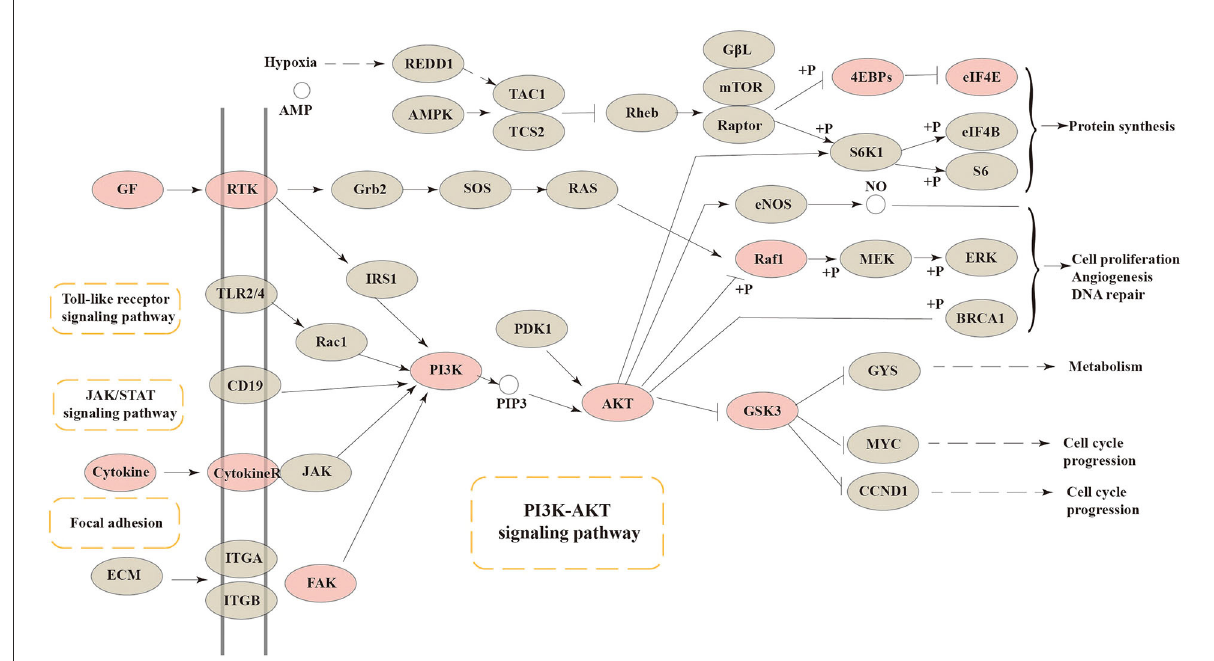
FIGURE6 The Kyoto Encyclopedia of Genes and Genomes (KEGG) pathway enrichment analysis showed that various targets of the PI3K-AKT signaling pathway were tightly associated with the peptides’ pharmaceutical actions. The red nodes represent the genes could be regulated or affected by fermented egg-milk peptides